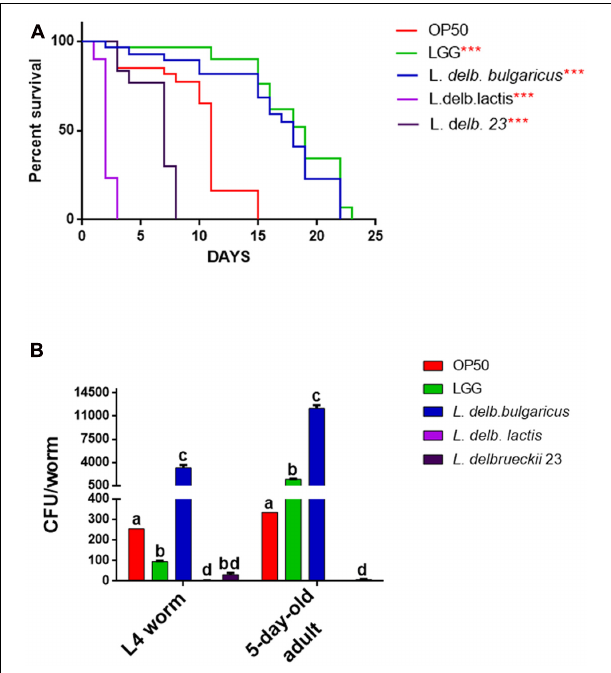
FIGURE 5 | Effect of L. delbrueckii subspecies on nematode lifespan and gut colonization capacity. (A) Kaplan–Mèier survival plot of N2 worms fed the three L. delbrueckii strains or controls (LGG and Escherichia coli OP50); n = 60 for each data point of single experiments. Asterisks indicate the P -values (log-rank test) with respect to the control E. coli OP50. Different letters indicate statistically significant differences ( P < 0.05). (B) Bacterial colony forming units (CFU) recovered from nematodes, obtained by plating whole lysates of L4 and 5-days adults fed the three L. delbrueckii strains or controls (LGG and E. coli OP50). Bars represent the mean of three independent experiments.